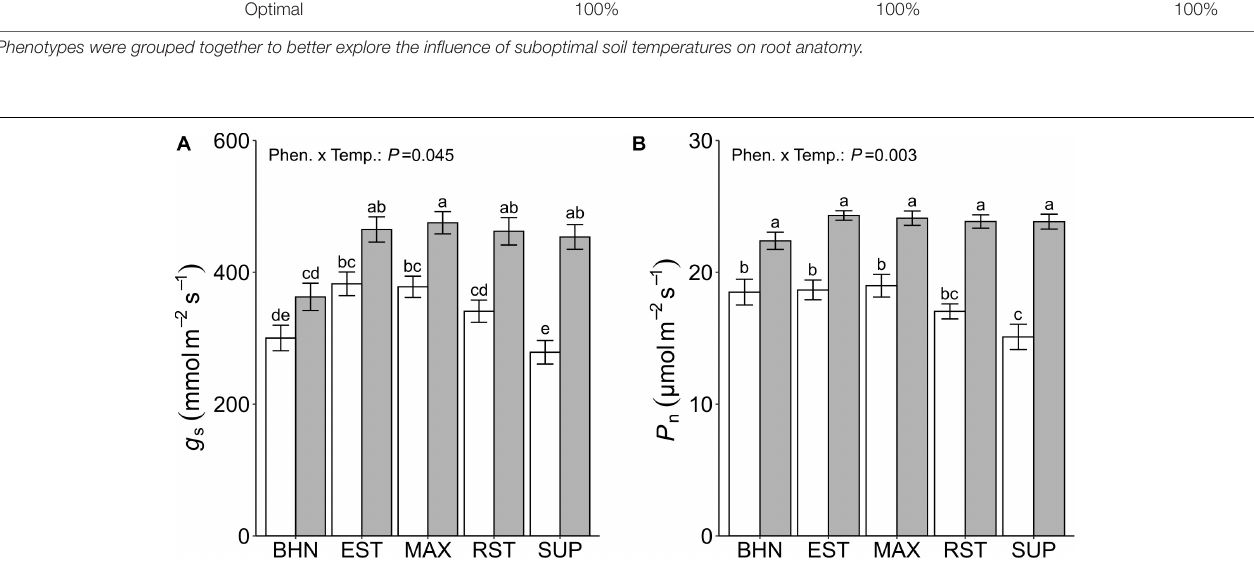
FIGURE 3 | Stomatal conductance ( g s ; A ), and photosynthetic rate ( P n ; B ) of four grafted rootstocks (Estamino, Maxifort, RST-04-106-T, and Supernatural) and one cultivar (BHN-589) grown under optimal (gray) and suboptimal (white) soil temperatures for 4 weeks. All rootstocks were grafted with BHN-589. Values are mean ± standard error ( A: n = 14 and 48 total measurements; B: n = 6 and 24 total measurements) Means followed by different letters are statistically different at P < 0.01.